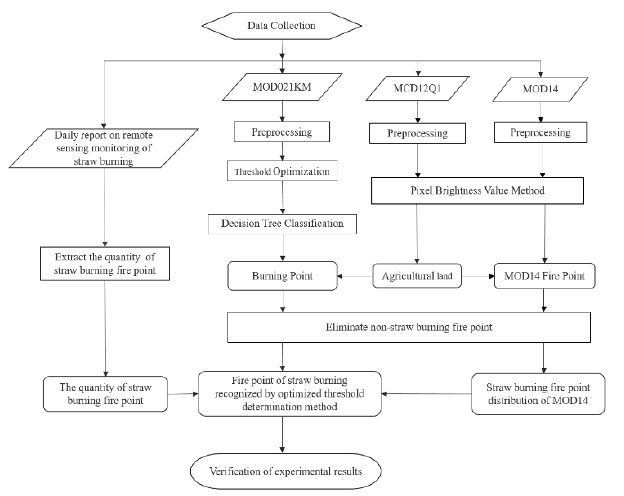
Figure 2 . Workflow of the optimized threshold determination